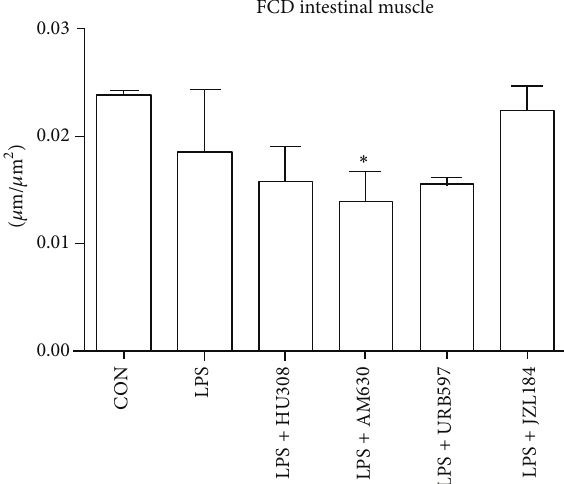
Figure 3: Functional capillary density (FCD) as a measure of capillary perfusion within the muscle layers of the intestine. Calculated as total length of capillaries with erythrocyte perfusion within a predetermined rectangular field. Control group (CON); endotoxemia group LPS (5mg/kg); LPS + HU308 (2.5 mg/kg), a CB 2 receptor agonist; LPS + AM630 (2.5 mg/kg), a CB 2 receptor antagonist/inverse agonist; LPS + URB597 (0.6mg/kg), a FAAH inhibitor; and LPS + JZL184 (16mg/kg), a MAGL inhibitor. In every animal six intestinal muscle regions were analyzed ( 𝑛 = 3 –5 mice/group). Data presented as mean ± standard deviation. ∗ 𝑃 < 0.05 versus control.